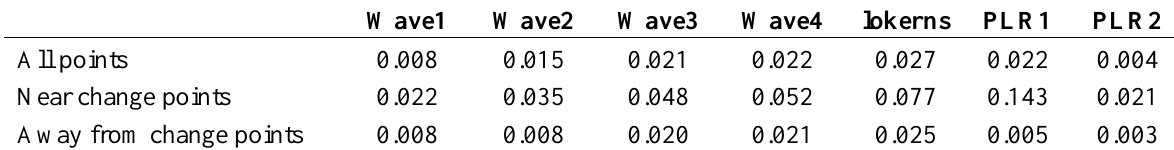
Table 4. The RRMSE for the 4 wavelet options, PLR, and local kernel smoothing on data